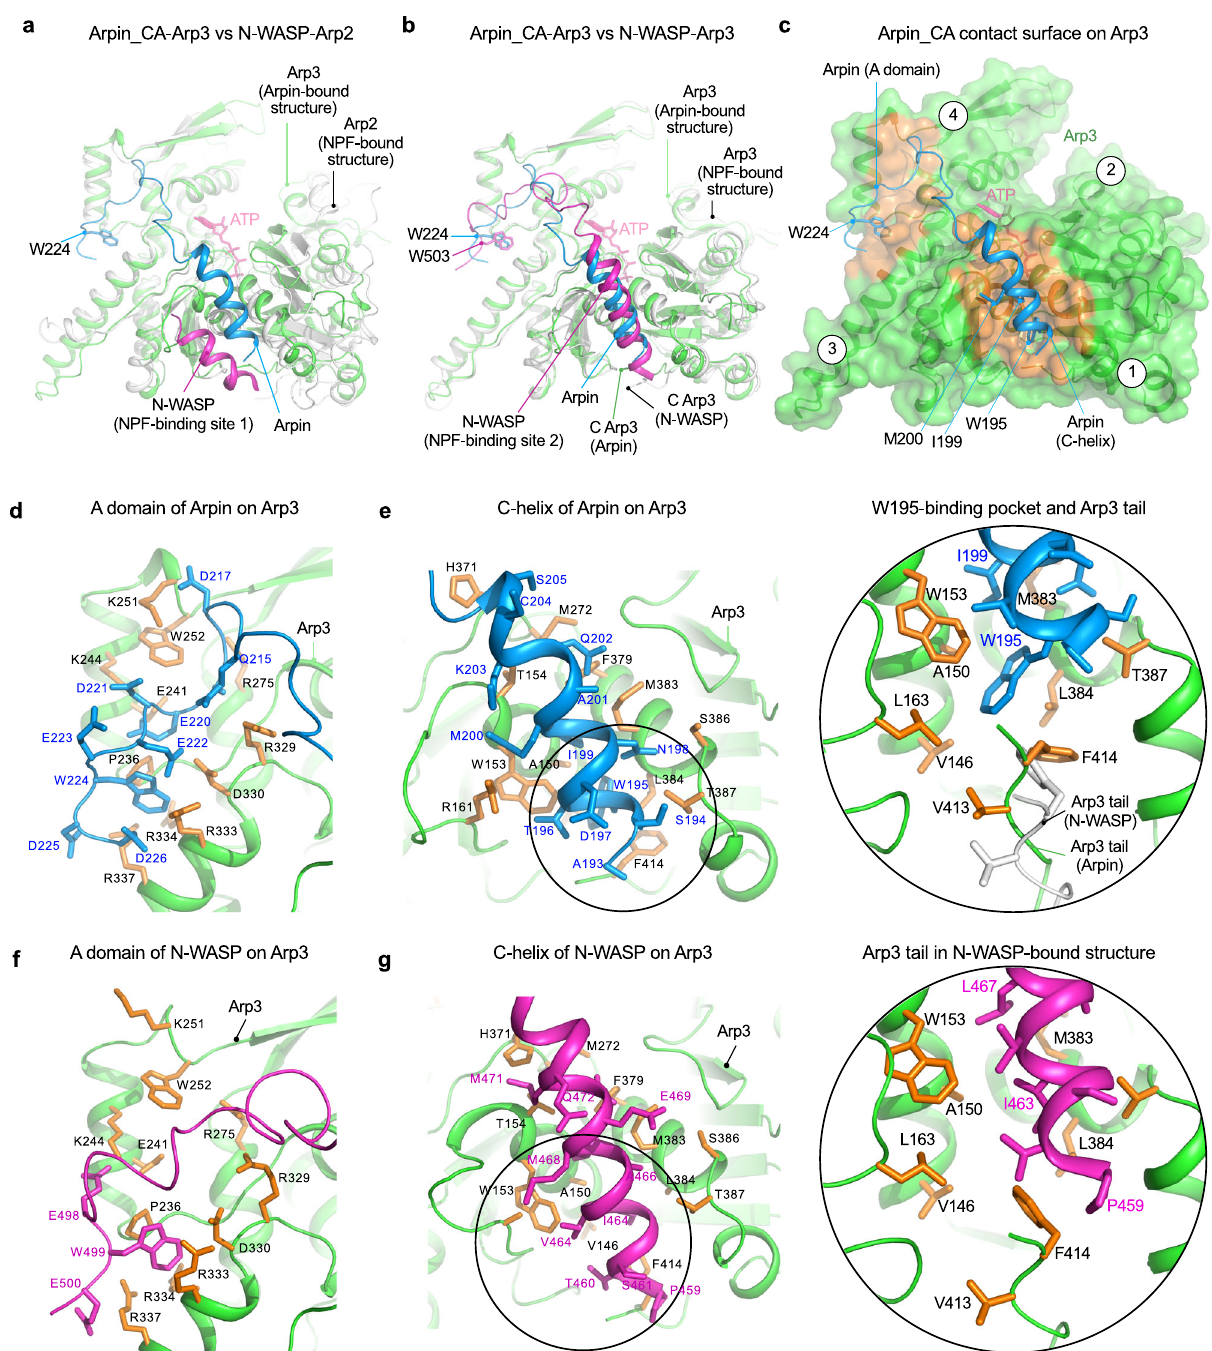
Fig. 3 Interactions of Arpin and N-WASP with Arp2/3 complex. a , b Superimposition of Arpin_CA-Arp3 (marine blue and green) onto N-WASP-Arp2 ( a ) and N-WASP-Arp3 ( b ) (magenta and gray). c The contact surface (orange) of Arpin on Arp3 involves Arpin ’ s C-helix and the A domain, whereas the negatively charged linker between these two regions is fl exible and does not participate in speci fi c contacts. d – g Comparison of the speci fi c interactions of the A domain ( d and f ) and C-helix ( e and g ) of Arpin and N-WASP with Arp3 (green with orange side chains). Insets show details of the interactions of the C-helices of Arpin ( e ) and N-WASP ( g ) with the C-terminal tail of Arp3. The inset in part e shows a comparison of the C-terminal tail of Arp3 in both structures (green-orange, Arpin structure; gray, N-WASP